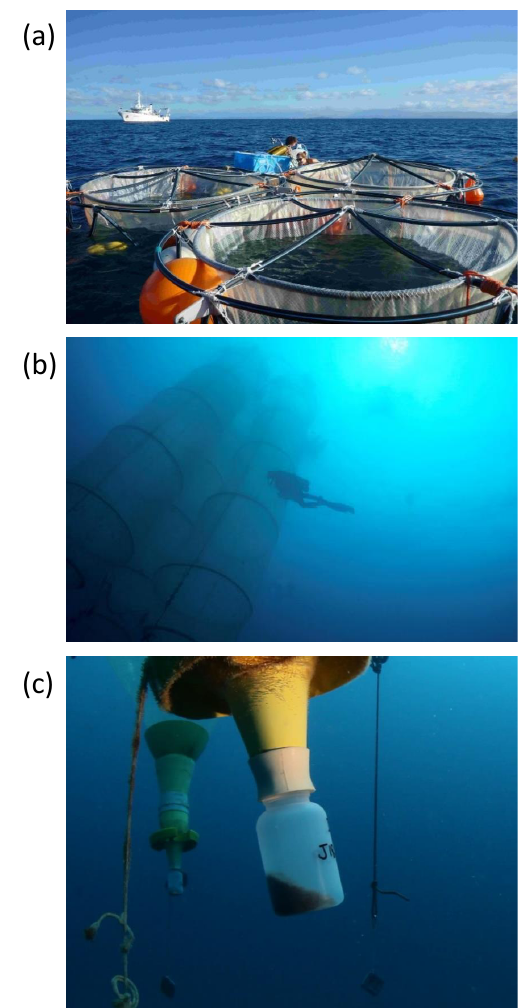
Figure 2. View of the mesocosms from above (a) , from the seafloor (b) and view of the sediment traps that collect sinking particles (c) . Photos credits: J. M. Boré and E. Folcher,